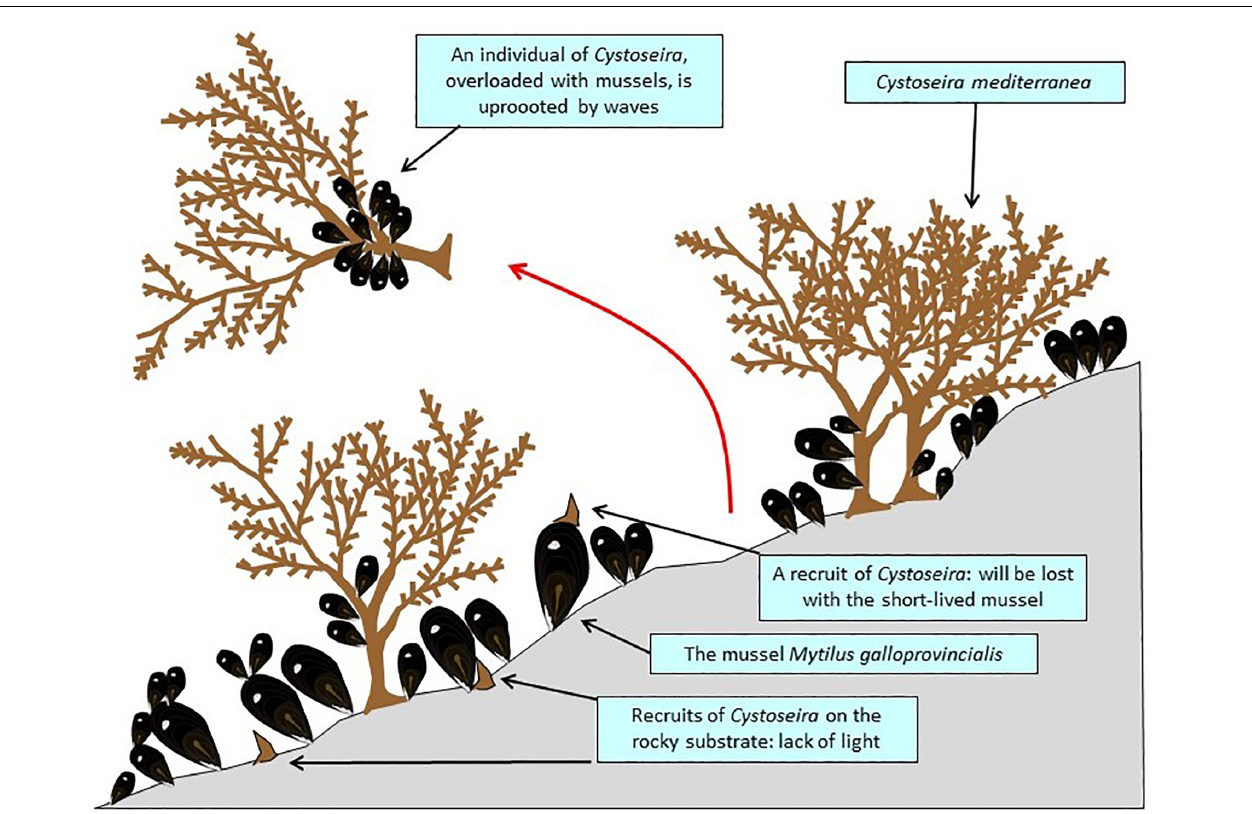
FIGURE 7 | A stand of Carpodesmia mediterranea (= C ystoseira mediterranea ), in French Catalonia, severely disrupted by mussels of which the recruits probably come from offshore mussel farms.